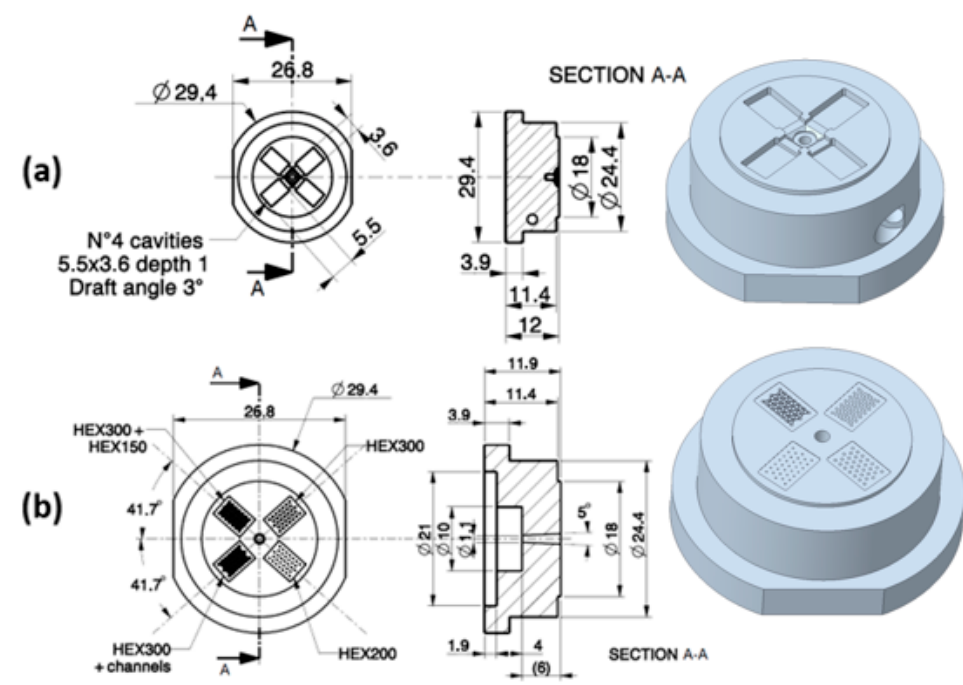
Figure 5. Mold inserts. ( a ) Ejection side; ( b ) injection side with dome micro-textures (mm). All micro-textures are based on spherical shapes, which are domes on the mold and cups on the samples. HEX300 and HEX200 are hexagonal patterns of cavities with diameters of 300 and 200 μ m, respectively. The HEX300-150 is designed with a hierarchy of two hexagonal patterns of cavities with diameters of 300 and 150 μ m. HEX300 with channels (HEX300+CH) is a hierarchized micro-texture obtained from HEX300, adding a pattern of 50 μ m width channels between cavities. In all textures, the pattern unit cell has a width of W = 0.700 mm and a length of L = 1.212 mm (Figure 4). The micro-cavities’ depth is H = 20 μ m. Parameters are reported in Table 1. Table 1. Micro-textures, geometrical parameters, and AF.